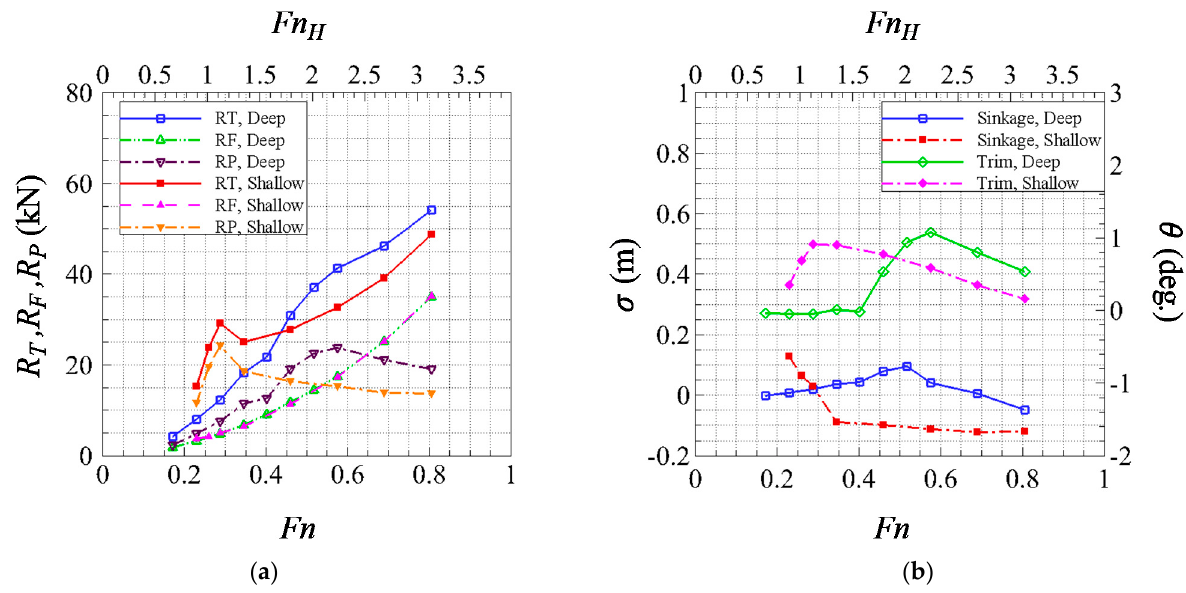
Figure 9. Comparison of resistances ( a ) and motions ( b ) of London Demonstrator in deep and shallow water ( H = 2.15 m).